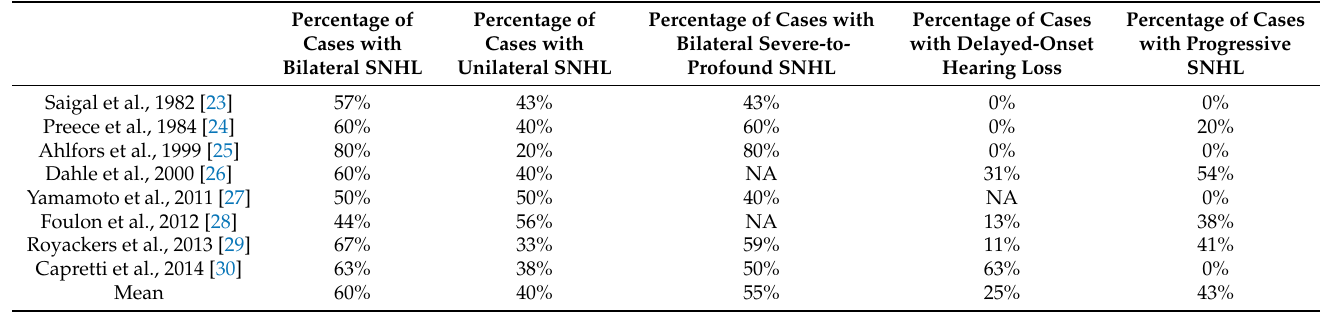
Table 1. The findings of eight cohort studies describing the characteristics of hearing loss due to cCMV infection. cCMV, congenital cytomegalovirus; NA, not available; SNHL, sensorineural hearing loss. Percentage of Cases